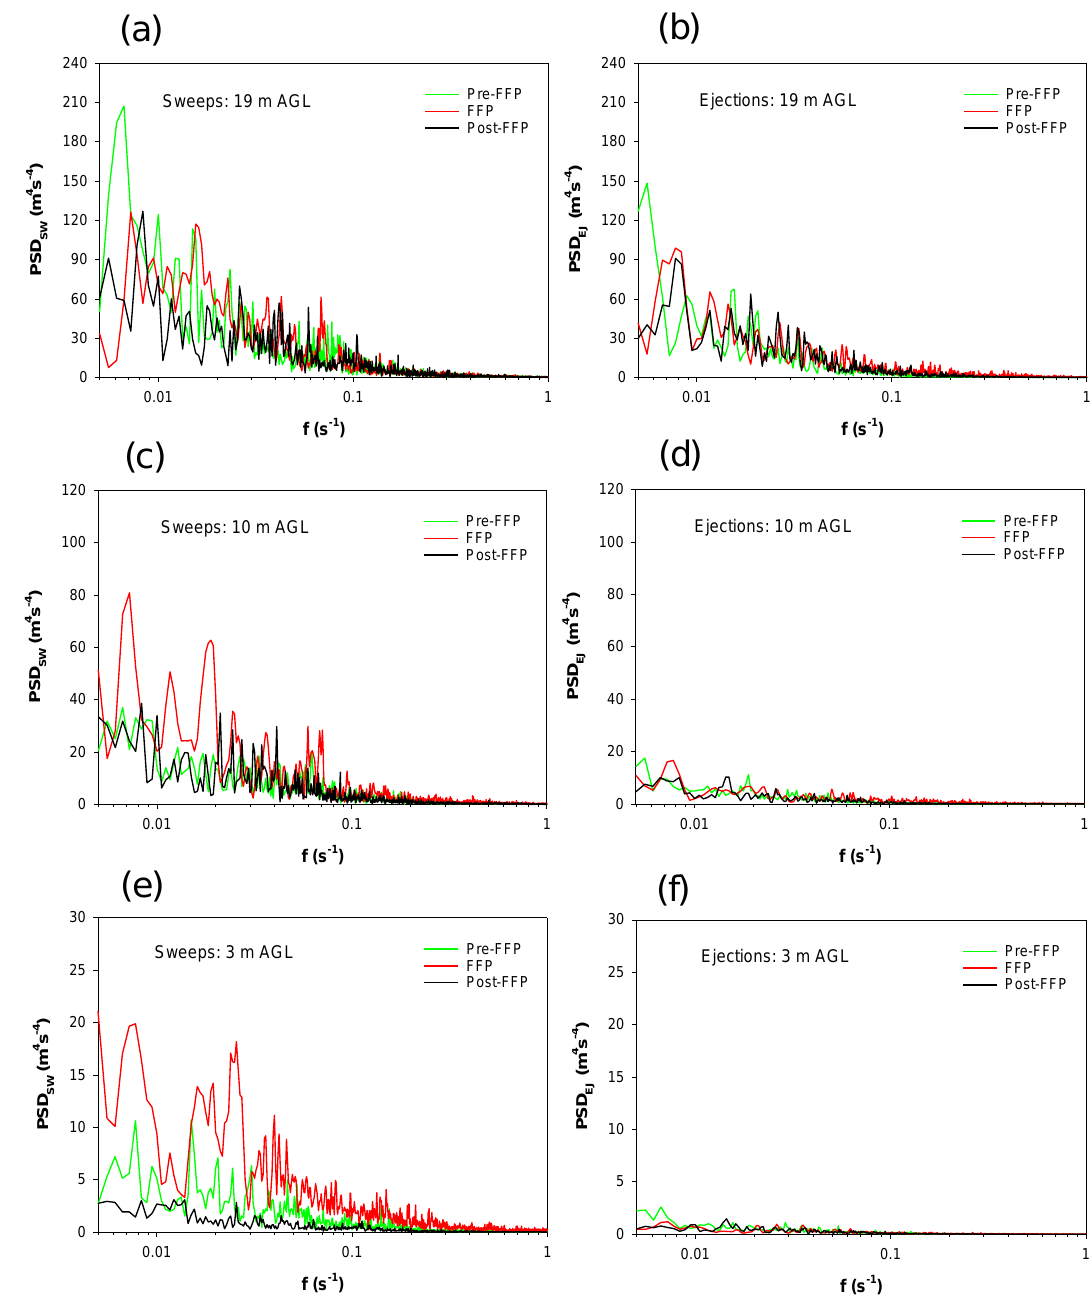
Figure 10. Mean power spectral density (PSD: m 4 s − 4 ) vs. frequency (f: s − 1 ) curves for the negative vertical momentum flux contributors of ( a , c , e ) sweeps (PSD SW ) and ( b , d , f ) ejections (PSD EJ ) at the 19-m (top row), 10-m (middle row), and 3-m (bottom row) levels for the pre-FFP, FFP, and post-FFP periods, computed from all five in situ